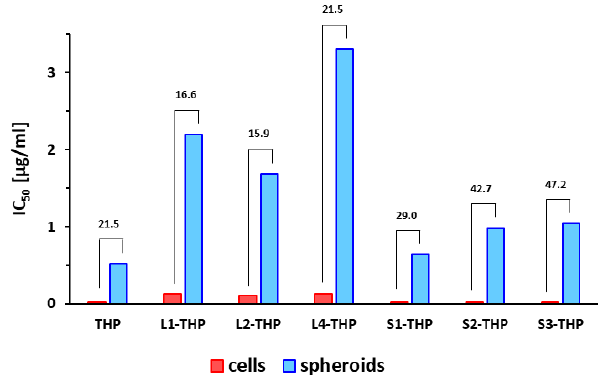
Figure 5. The cytotoxic effect of THP and THP-polymer conjugates on C26 monolayer cells and spheroids from the C26 cell line. The numbers above the bar graph represent the ratio of IC 50 on spheroids and IC 50 on 2D cells.